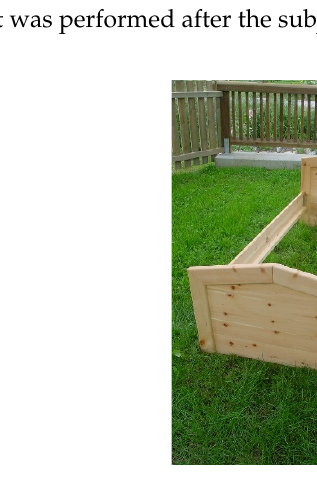
Figure 2. Bed types used in the study: melamine faced chipboard (( a ), control) and stone pine ( Pinus cembra ) solid wood bed ( b ). Six beds were made of each type. The personal beds of the 15 subjects are not shown.